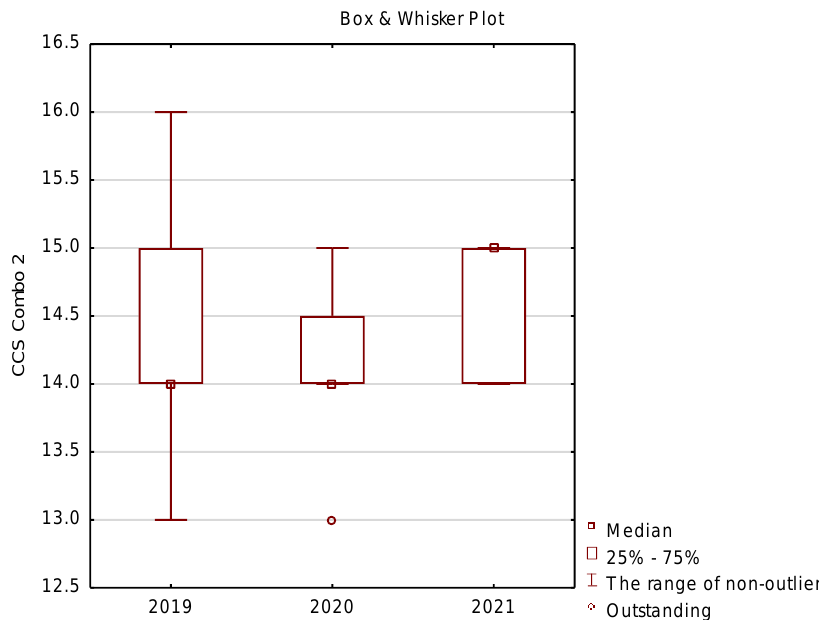
Figure 14. Box plots for the analysis of vehicle charging method — CCS Combo 2.